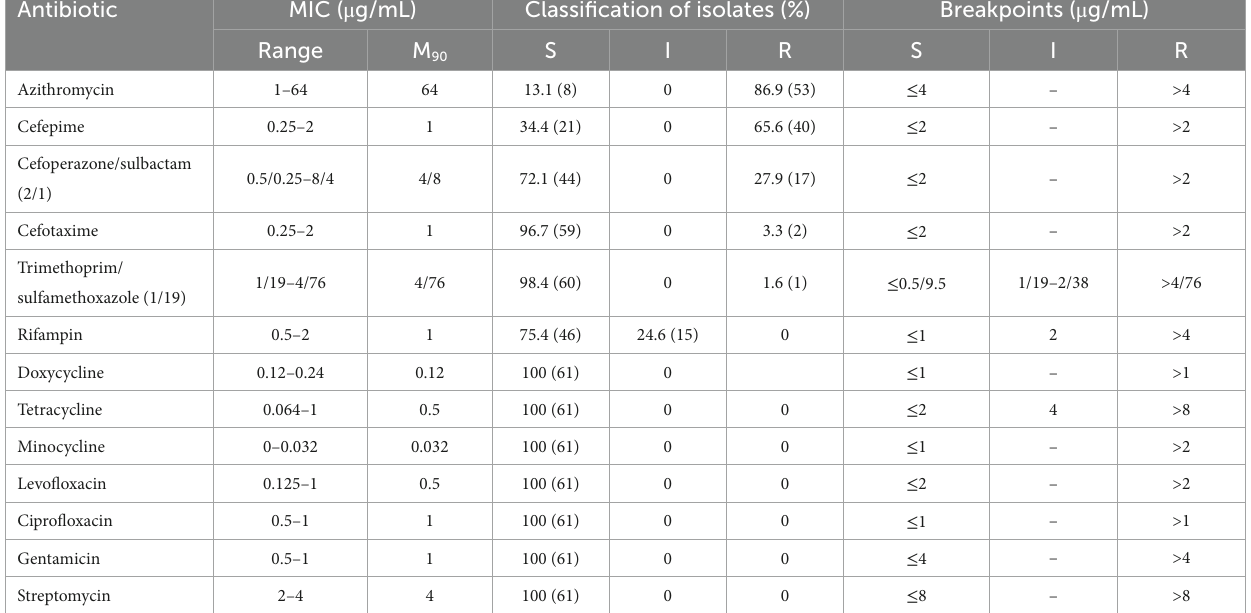
TABLE 2 MIC range and MIC 90 of 13 antibiotics against 61 Brucella isolates.